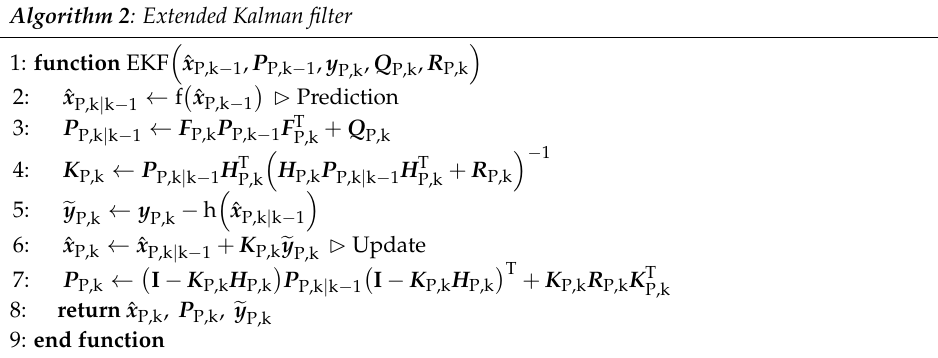
Algorithm 2 : Extended Kalman